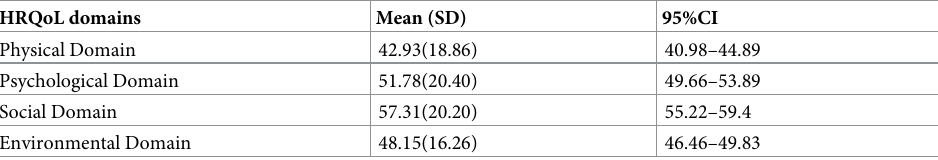
Table 3. Health related quality of life domain score of hypertension patients on treatment attending public health facilities in Dessie City Administration, Dessie, Northeast Ethiopia